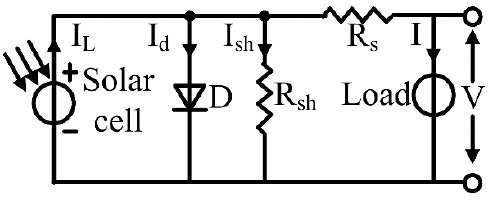
Figure 4. Equivalent circuit of the solar cell.